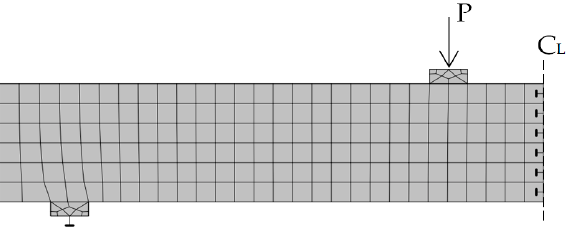
Figure 6. Finite element model of beam specimen using ATENA 2D.